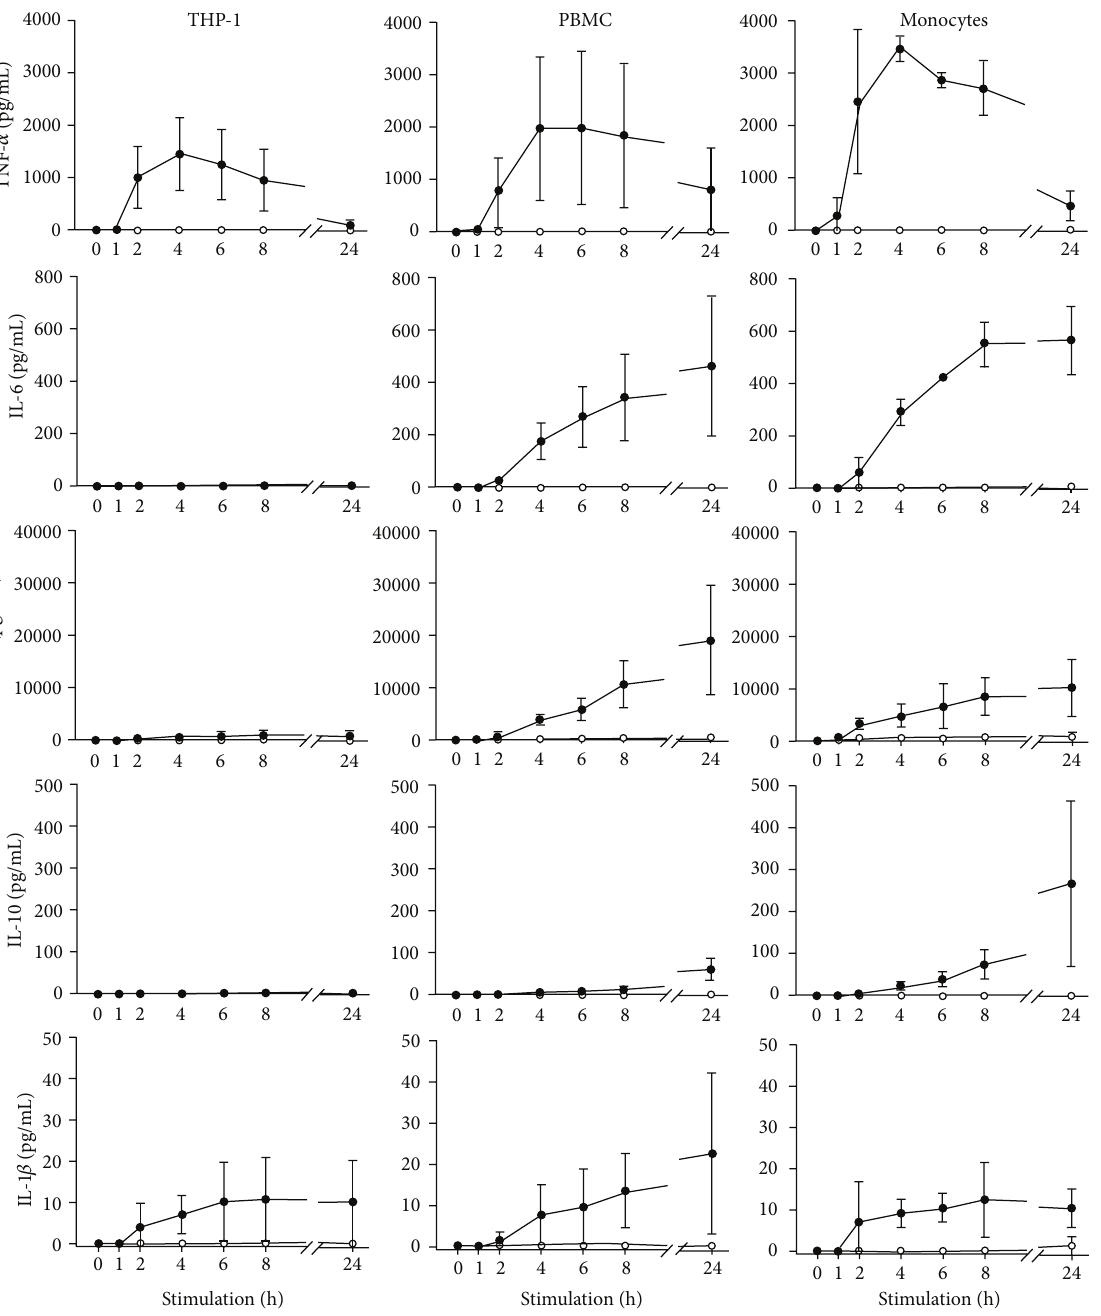
Figure 2: Cytokine release upon stimulation of THP-1, PBMC, and monocytes with lipopolysaccharide. Cultures of one million cells permL of medium containing 10vol% plasma were stimulated with 10ng permL of LPS from P. aeruginosa (black circles). Unstimulated cultures served as control (white circles). Concentrations of TNF- 𝛼 , IL-6, IL-8, IL-10, and IL-1beta are given as mean ± SD ( 𝑛 = 3 ).